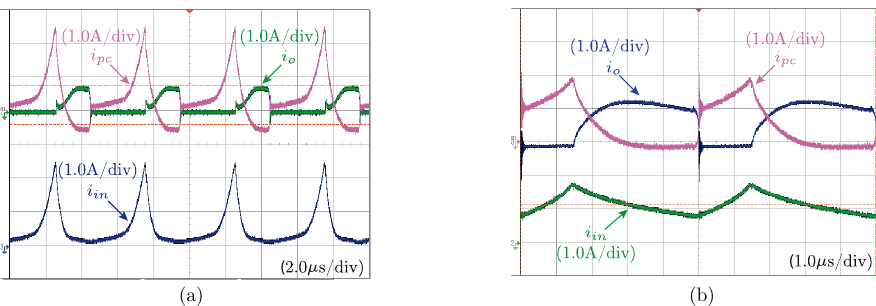
Figure 6. Current measurements. ( a ) With the clamping circuit and D = 0.63. ( b ) With the clamping circuit and D = 0.28.